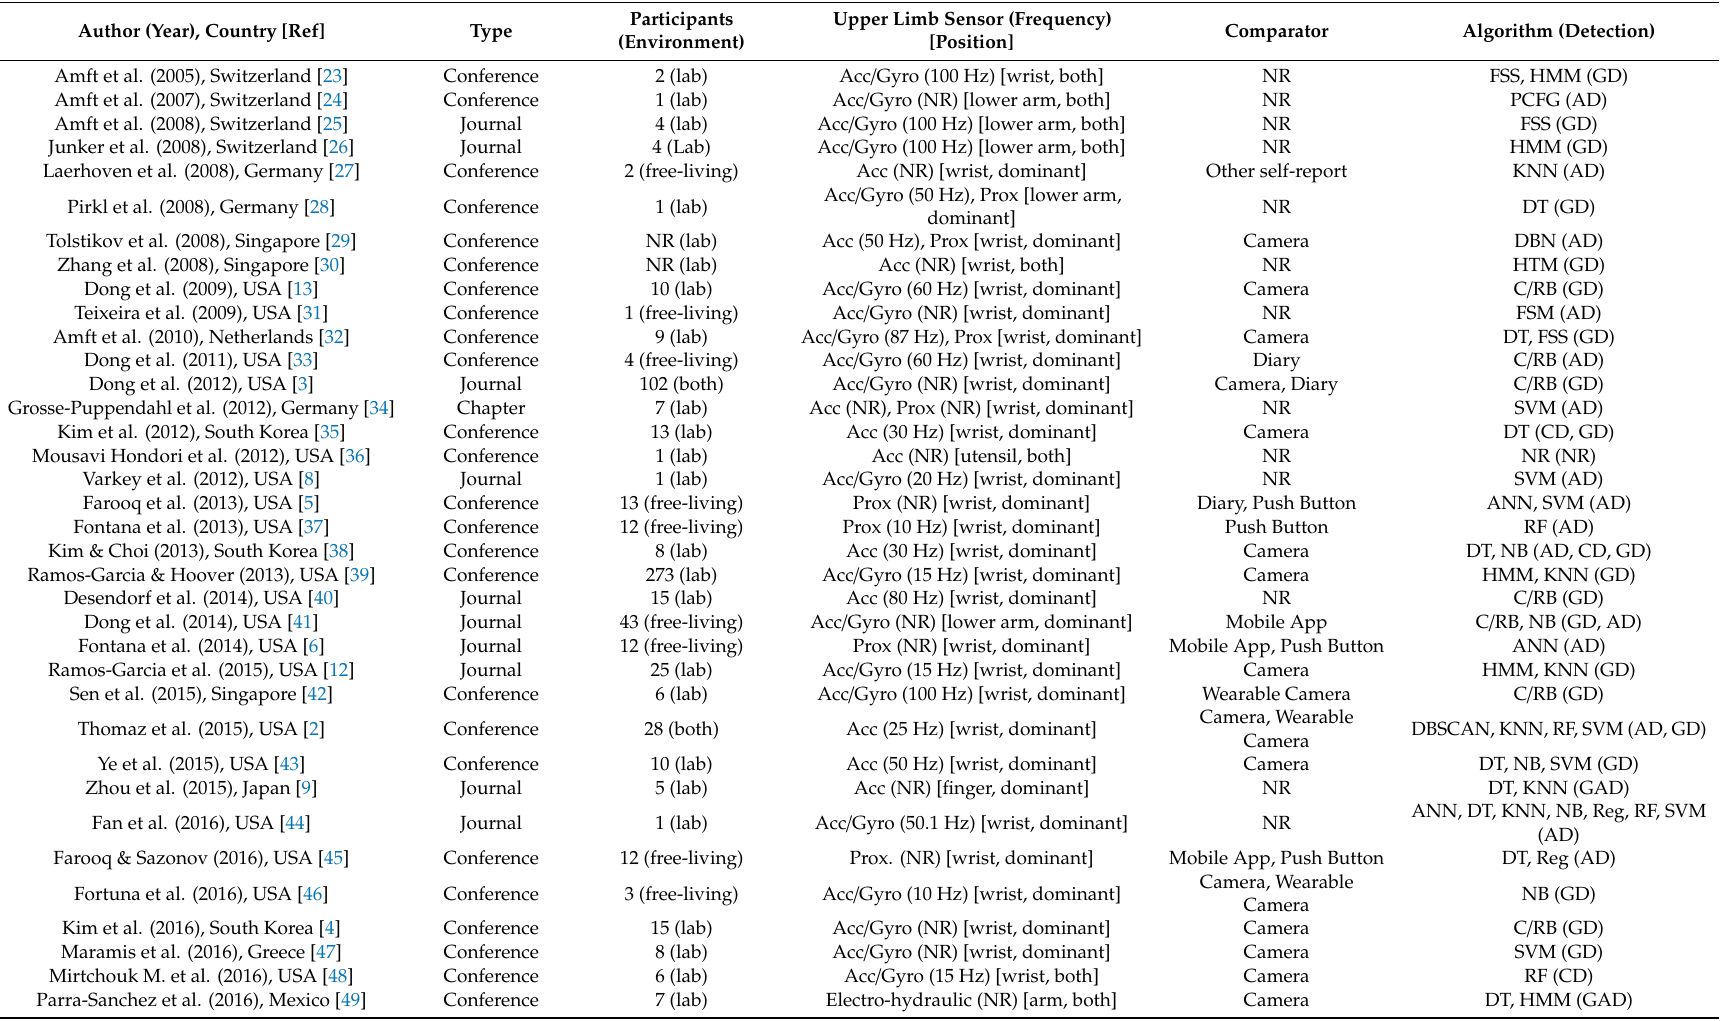
Table 2. Included studies ( n =